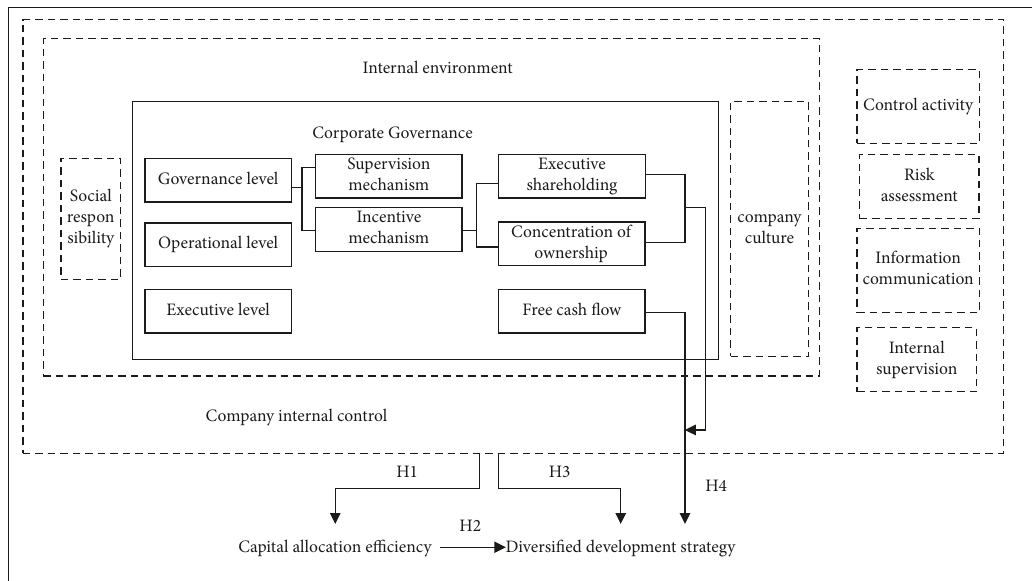
Figure 1: Relationship between internal control, internal capital allocation efficiency, and